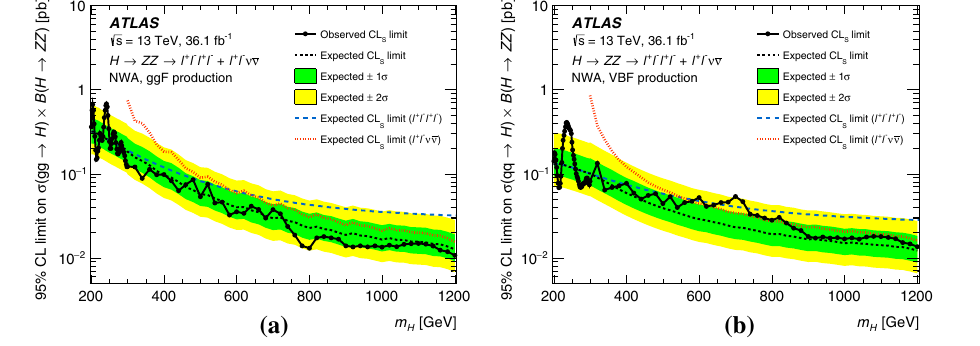
Fig. 6 The upper limits at 95% CL on the cross section times branch- ing ratio as a function of the heavy resonance mass m H for a the ggF production mode( σ ggF × B ( H → Z Z ) ) and b for the VBF production mode ( σ VBF × B ( H → Z Z ) ) in the case of the NWA. The green and